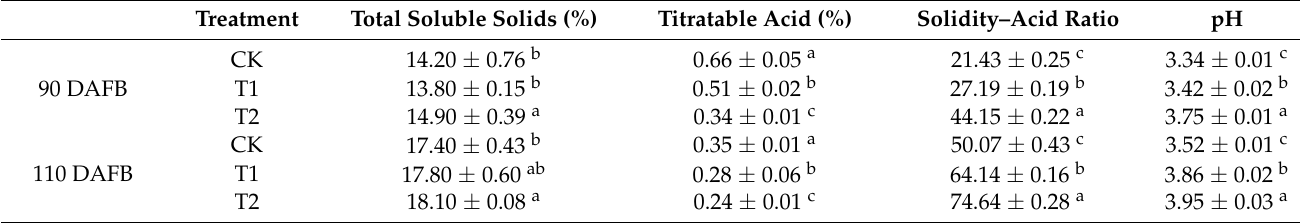
Table 1. Physicochemical indexes in ‘Kyoho’ grape berries under different potassium fertilizer treatments.